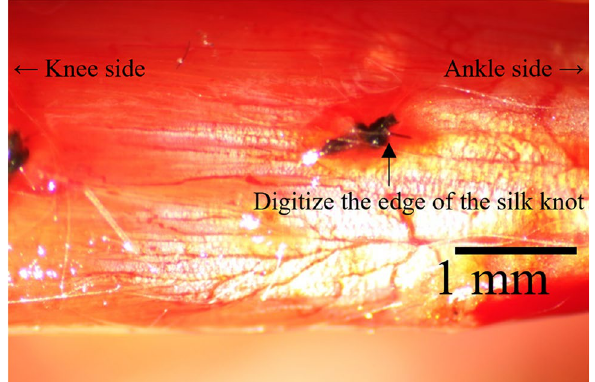
Figure 1. Typical image obtained by a microscope. The soleus and Achilles tendons were visualized under a microscope. The displacement of the knot tied near the end of the aponeurosis was recorded to examine tendon elongation during isometric contractions with high space resolution.